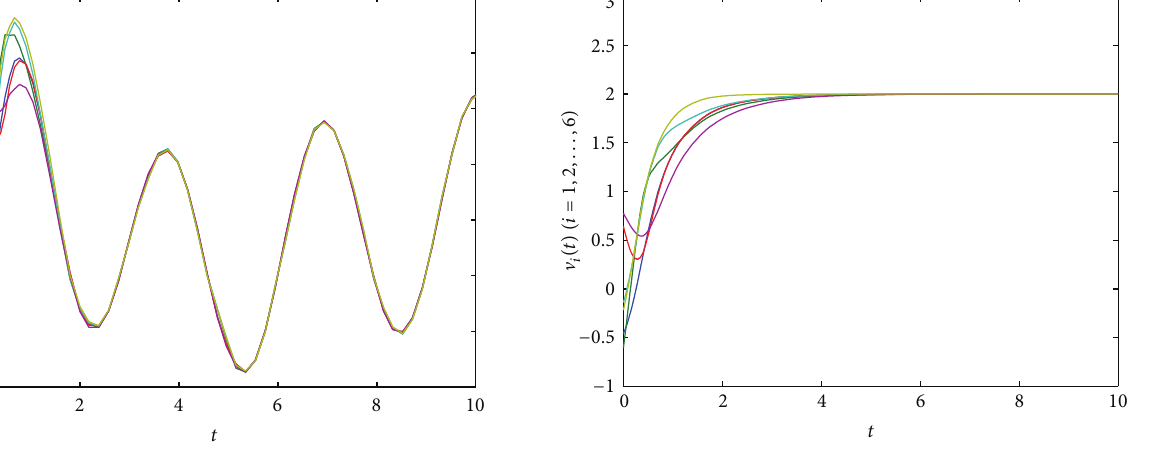
Figure 7: The velocity curves V 𝑖 (𝑡) (𝑖 = 1,2,...,6) for nonlinear multiagent systems (45) with 𝜏 0 = 0 , 𝜏 1 = 0.3